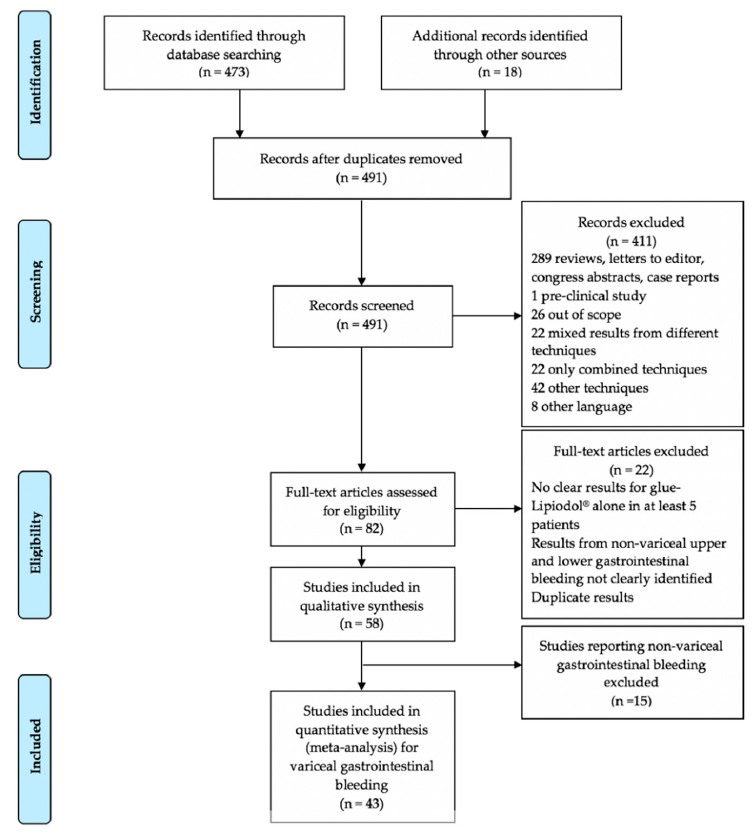
Figure 1. Preferred Reporting Items for Systematic Reviews and Meta-Analyses (PRISMA) flow diagram of the article selection process.